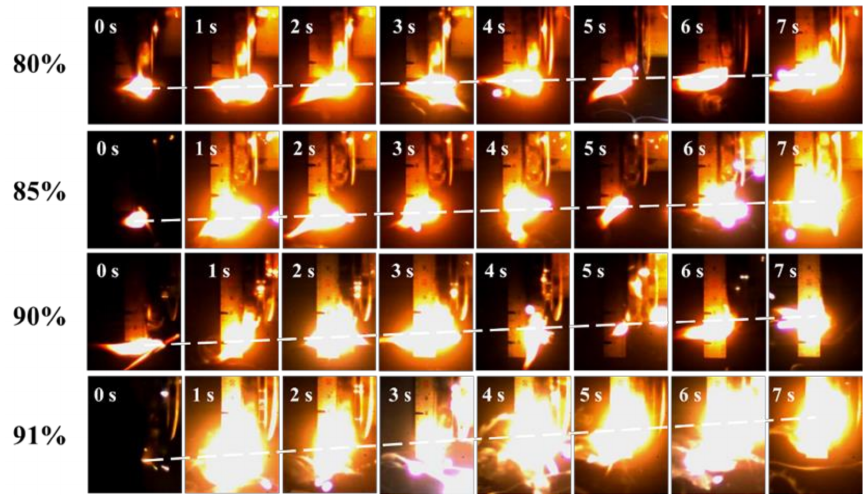
Figure 6. Combustion images of samples with different solid